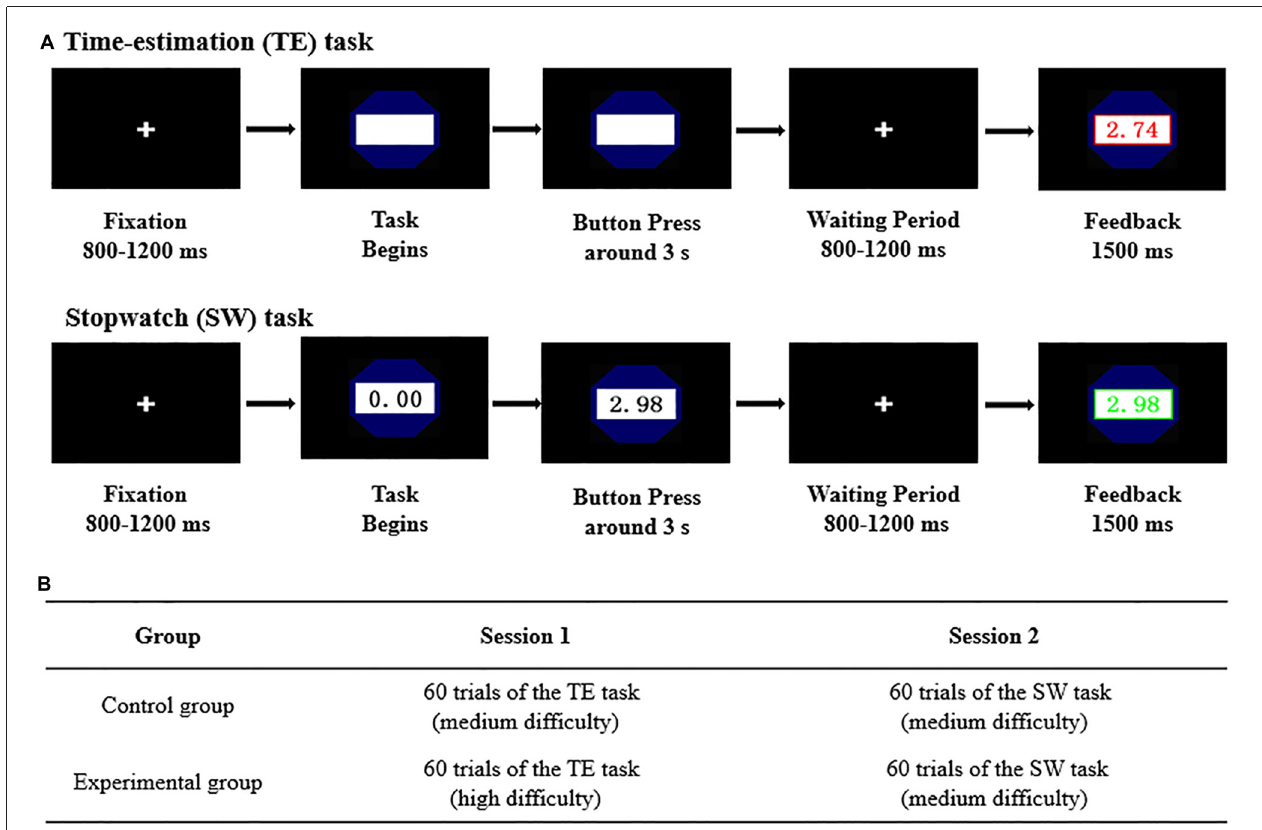
FIGURE 1 | The experimental paradigm. (A) Illustration of time-estimation (TE) and stopwatch (SW) tasks. (B) Demonstration of the experimental